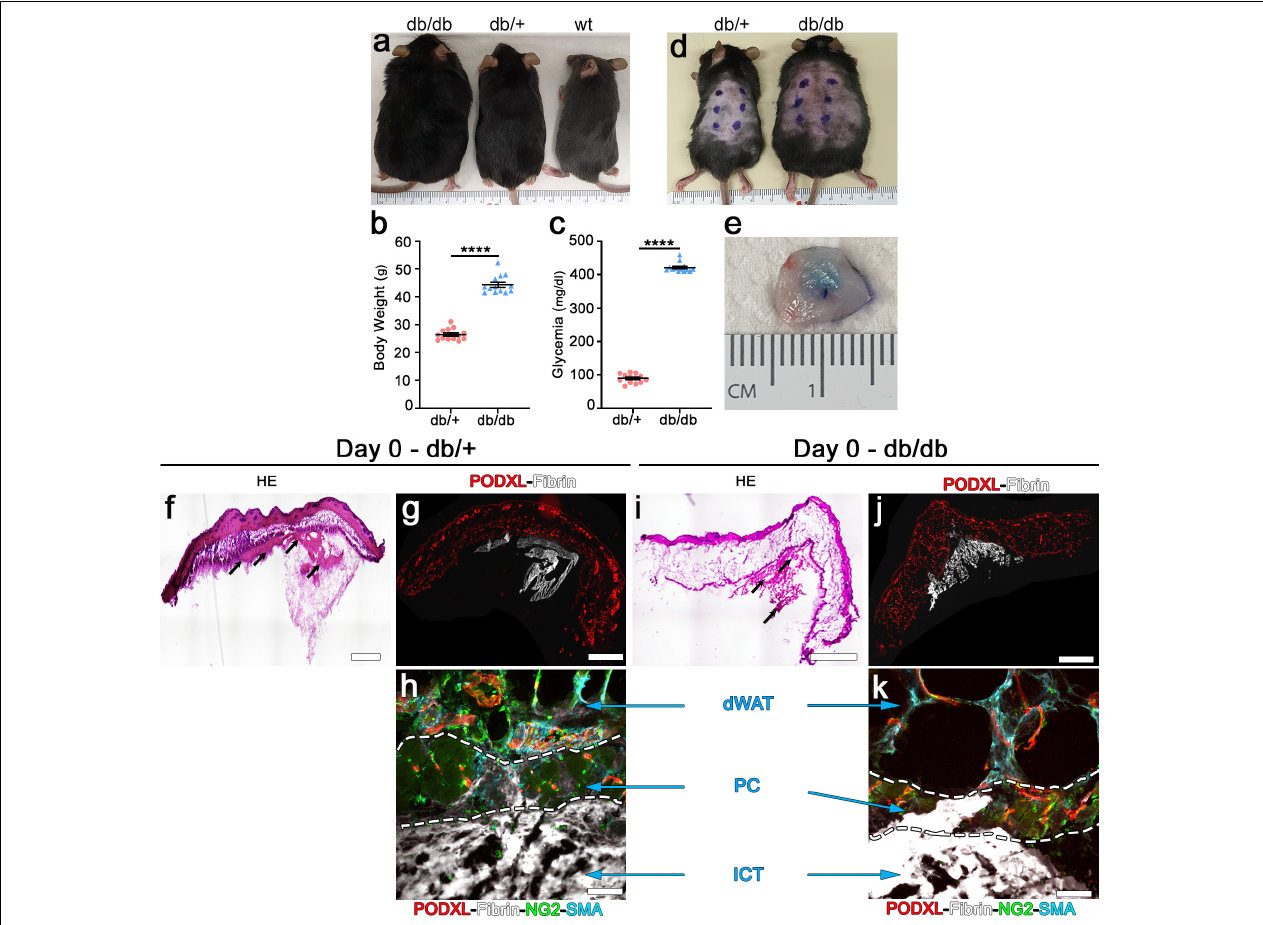
FIGURE 1 | Intradermal injection and retention of fibrin gels in the skin of db mice. (a) Phenotype of diabetic db/db (left), heterozygous db/+ (center) and wild-type (wt, right) mice at 10 weeks of age. (b) Body weight measurements and (c) blood glucose levels of db/db diabetic mice and heterozygous db/+ littermates used as control for all the studies. Data represent mean values ± SEM. **** p < 0.0001 by the Mann–Whitney test; n = 13 animals per group. (d) Location of the intradermal implantations of fibrin gels in the back skin of heterozygous db/+ (left) and diabetic db/db (right) mice at 10 weeks of age (6 injections/mouse). (e) Fluorescent fibrinogen is visibly retained in the dermal skin layer after injection (Day 0). (f,i) H&E staining of skin cryosections showing the location of the fibrin gels (black arrows) after injection in heterozygous (f) and diabetic (i) mice. (g,h,j,k) Immunofluorescence staining for endothelium (podocalyxin, red), fluorescent fibrinogen (white), pericytes (NG2, green), and smooth muscle cells ( α -SMA, cyan). (h,k) The injected fibrin gel is localized to the interstitial connective tissue (ICT) of dermis, under the dermal adipose white tissue (dWAT), and panniculus carnosus muscle